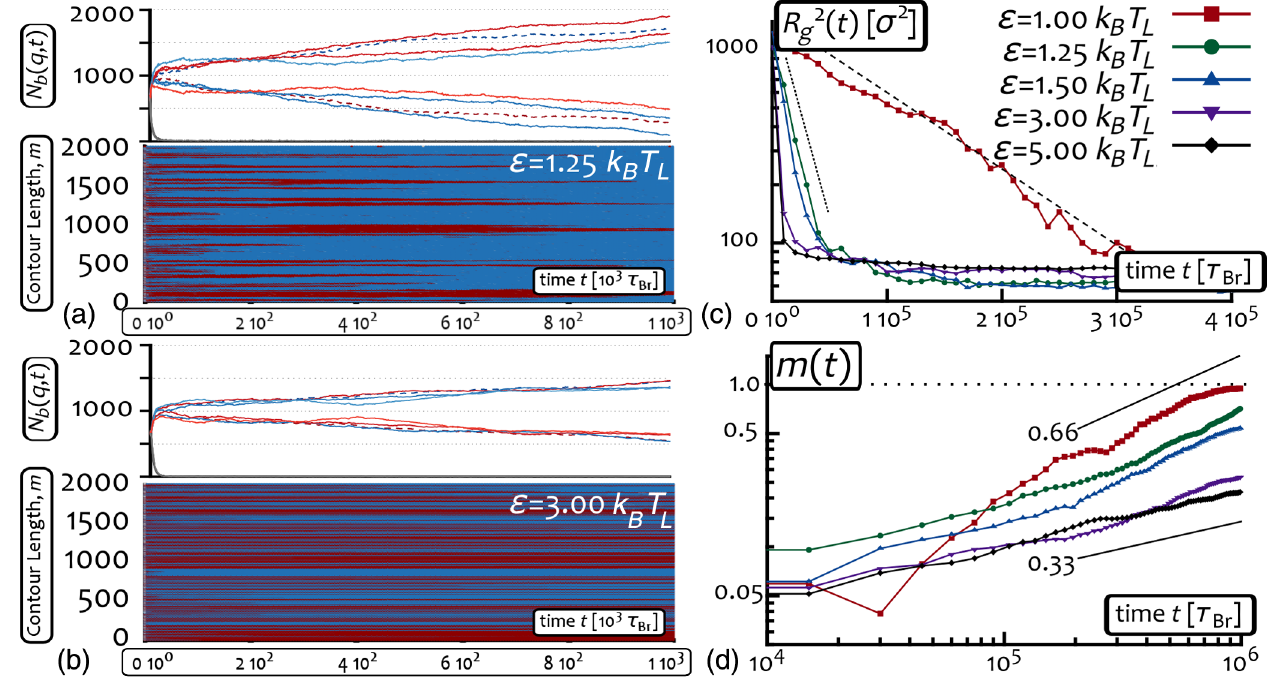
FIG. 4. Within the two-state model, epigenetic dynamics slows down with increasing α . (a,b) These panels show the kymographs and the ≃ 0 . 9 for M ¼ 2000 ). Counterintuitively, the symmetry q; t Þ , for twovalues of α above the critical point ( α number of beads in state q , N b ð c breaking of the chain towards an epigenetically coherent state slows down with increasing interaction strengths (compare also with Fig. 2). (c) This panel shows the time evolution of the squared gyration radius R 2 of the polymer from the moment the collapse starts. (d) This panel g (see also Movie 3 in Ref. [54]) shows the behavior of the epigenetic magnetization [defined in Eq. (3)] as a function of time. As expected, larger values of α therefore lead to a faster polymer collapse dynamics (faster decay of R ); surprisingly, however, this is accompanied by a g slower recoloring dynamics towards the epigenetically coherent state [slower growth of m ð t Þ ]. The longevity of the epigenetic domains thereby formed can bequantified bylooking atthegrowth of the epigenetic magnetization. For α ¼ 5 , m ð t Þ can be extrapolatedto reach,say, 0.5 at about 3 10 7 τ , which corresponds to 5000 minutes of physical time according to our time mapping (see Sec. Br